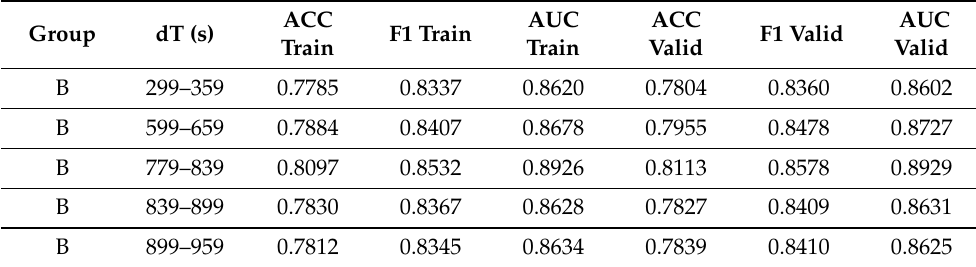
Table 2. GLM classifier results for Group B: all signals and 60 s time intervals.